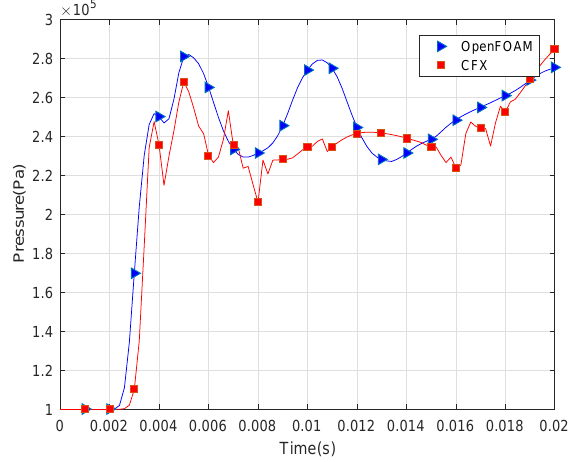
Figure 11. Pressure of the left observation point on the top of the